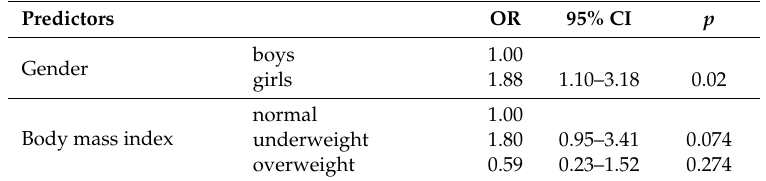
Table 5. Multiple regression analysis predicting health compromising eating behaviours from study